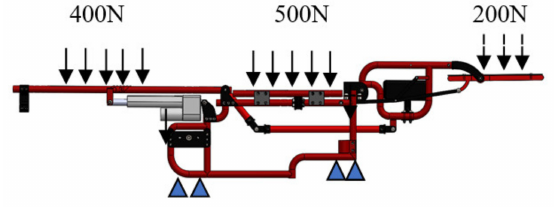
Figure 8. Simplify wheelchair in rest position and boundary